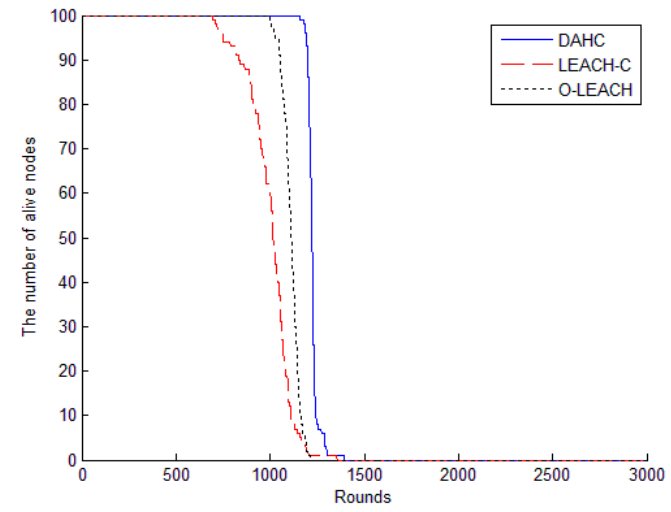
Figure 5. The number of alive nodes versus rounds when the BS is inside.